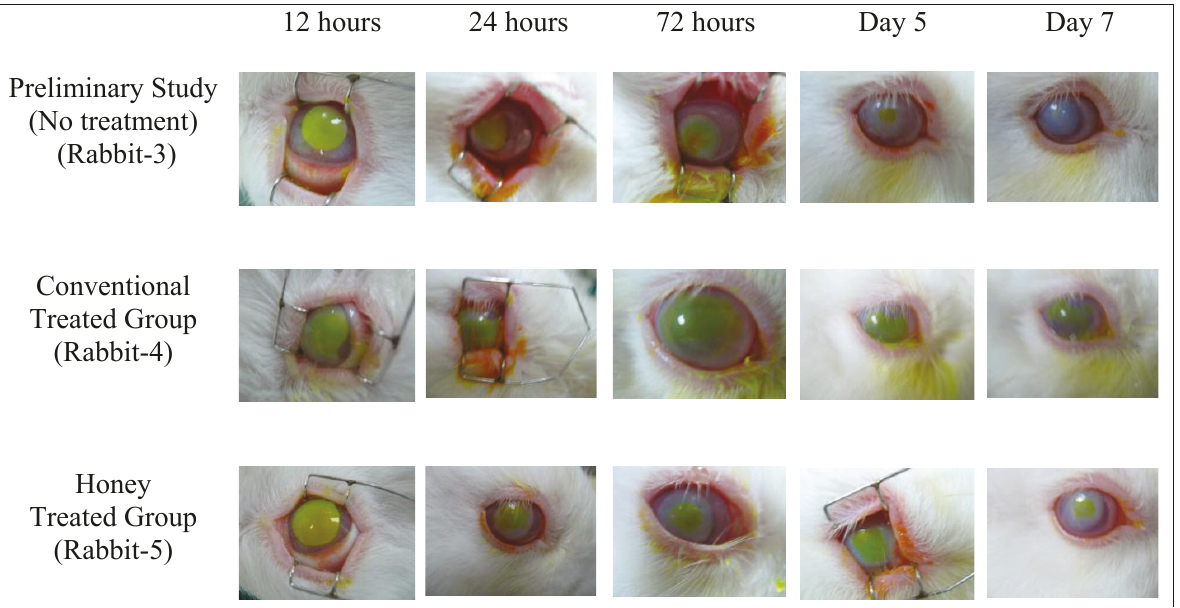
Figure 2 Corneal epithelial defect post induction of alkali injury on rabbit ’ s cornea